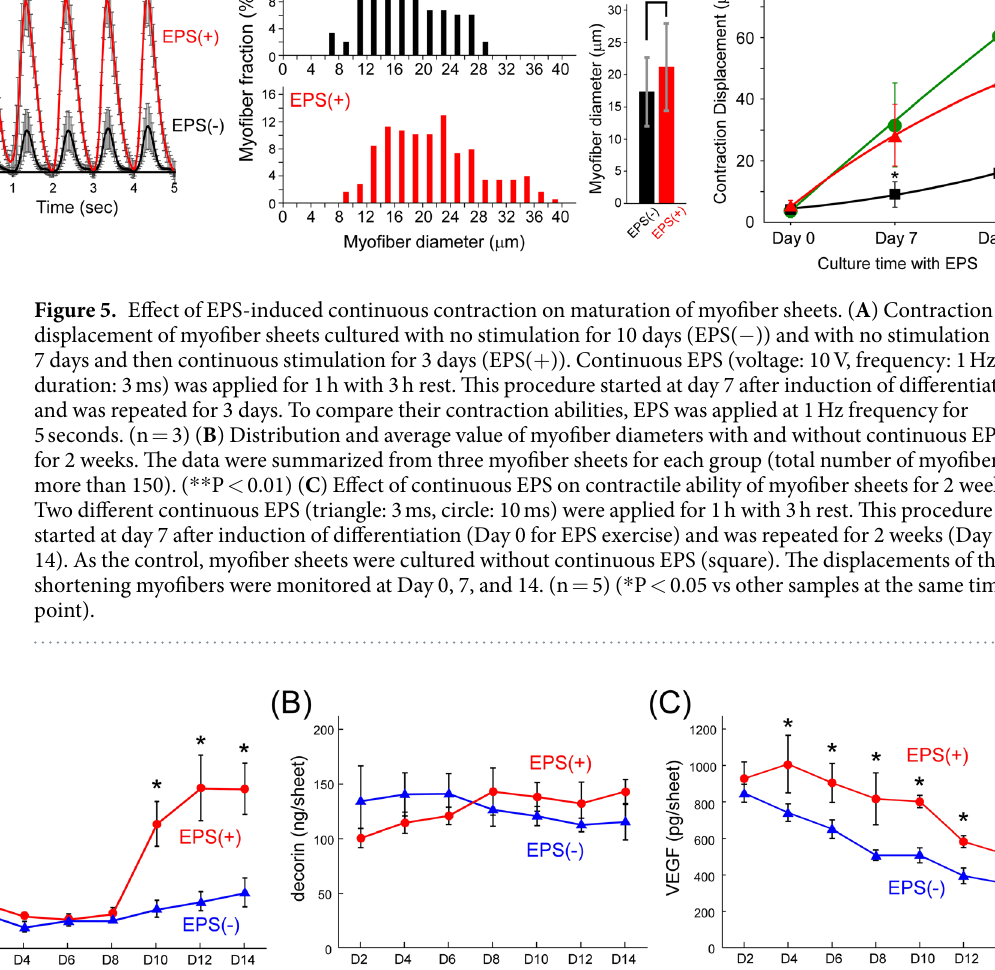
Figure 6. Profiles of cytokine secretion from myofiber sheets with (EPS( + )) and without continuous electrical stimulation (EPS( − )) (( A ) IL-6, ( B ) decorin, ( C ) VEGF). At Day 7 after induction of differentiation, EPS application (voltage: 10 V, frequency: 1 Hz, duration: 3 ms) was started (Day 0), and culture media were collected every other day for 2 weeks (from Day 2 to Day 14). Representative profiles are shown (n = 3). The significant difference between EPS( + ) and EPS( − ) groups was considered at each day ( * P < 0.05 at the same time